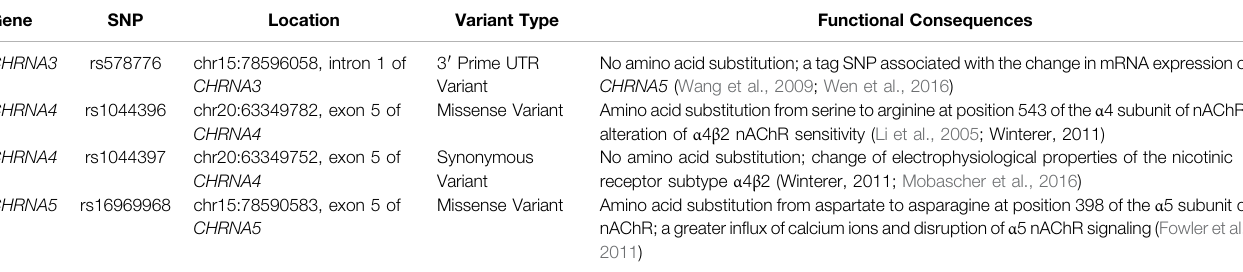
TABLE 6 | Summary of the polymorphic variants examined and their association with previously reported functional